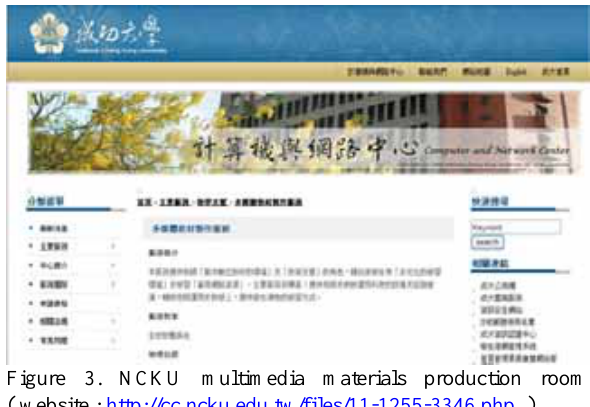
Figure 3. NCKU multimedia materials production room ( website : http://cc.ncku.edu.tw/files/11-1255-3346.php